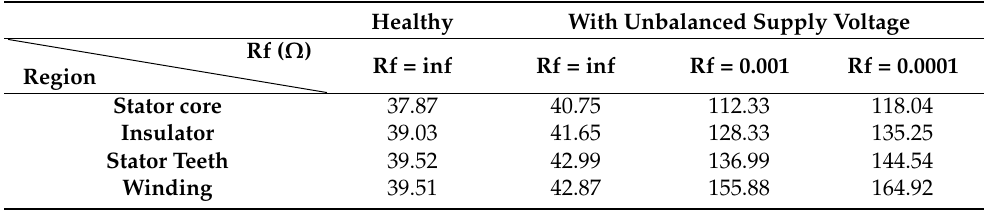
Table 6. IM steady-state temperature values ( ◦ C) under the occurrence of two inter-turns short-circuit.